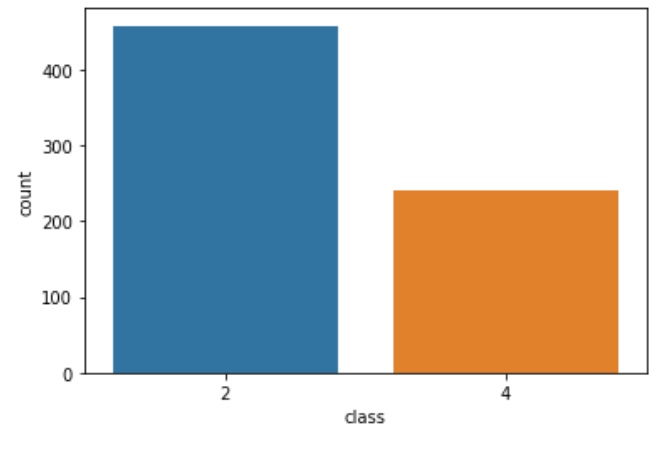
Figure 2. The number of benign and malignant cases; 2- benign 4-malignant.